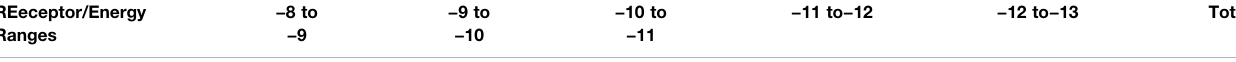
TABLE 2 | Comparison of two binding energy distributions (receptor- fl ex vs . receptor-rigid) for compounds with molecular weight lower than 400 Da. REeceptor/Energy Ranges